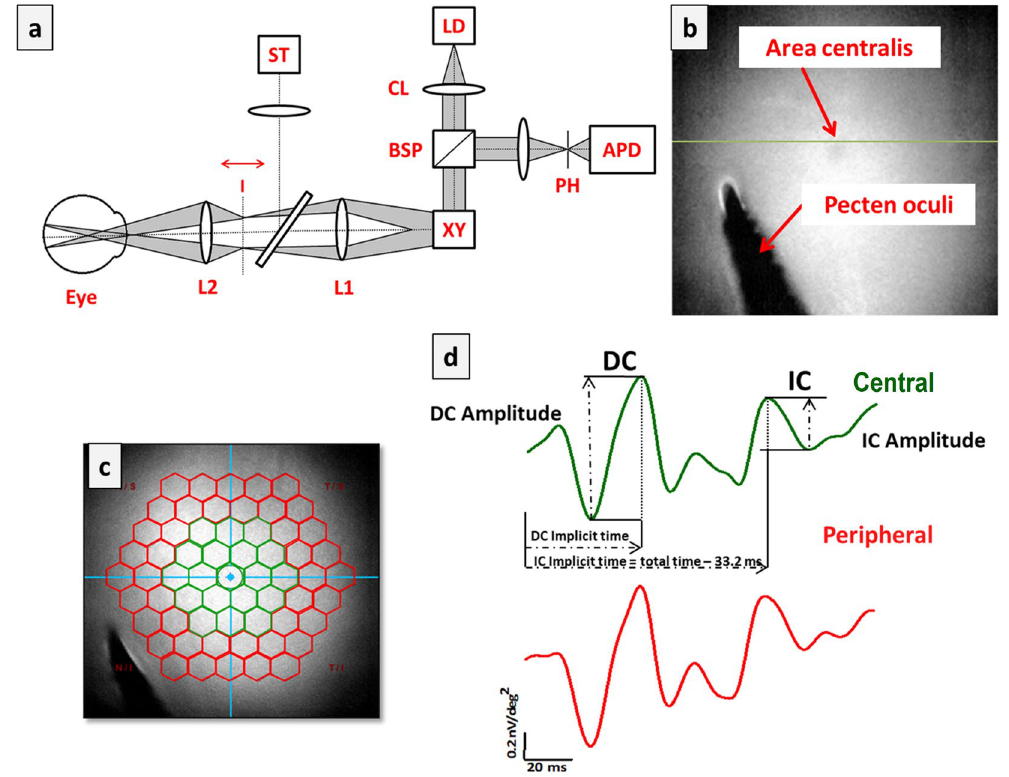
Figure 4. Experimental Setup, fundus image acquisition and MOFO stimulation. ( a ) Optical path of Roland Reti-Scan System, which consists of a laser point source [D], collimation lens [CL], beam splitter [BPS], scanning unit [XY], pinhole [PH], photodiode [APD], lens 1[L1] and 2 [L2], intermediate image [I], and stimulus projector [ST]. The refractive error of the eye is corrected by adjusting the intermediate image [I] using the focusing knob of the imaging system. ( b ) Fundus image of a chicken eye (12 days old) captured during OCT imaging (cSLO-OCT), also showing the location of the line scan indicated by a green line. ( c ) A fundus image superimposed by 61 unscaled hexagons (multifocal stimulation) obtained from cSLO system, showing the alignment of the center of stimuli with the area centralis. The regional responses obtained using multifocal stimulation was grouped into two regions: Central (green) and peripheral (red) regions for data analysis. ( d ) Representative mfERG waveforms obtained from the two regions (central and peripheral) in a control bird using the MOFO protocol. The measurements of the amplitude and implicit times of DC and IC components are indicated in the top